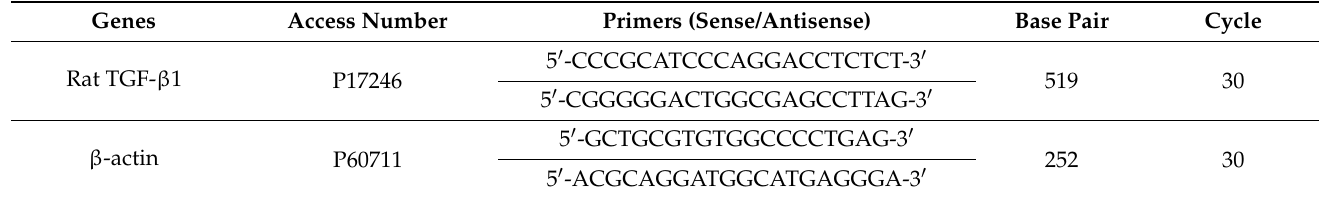
Table 2. Primers of nucleic acid sequence and reaction parameters. Genes Access Number Primers (Sense/Antisense) Base